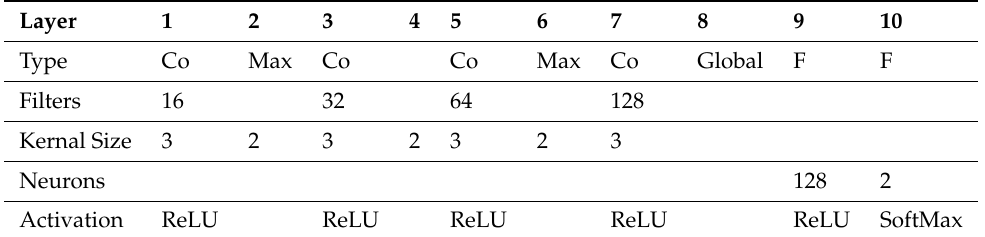
Table 1. CNN Architecture, Co a , the Max b , Global c , F d , ReLU e